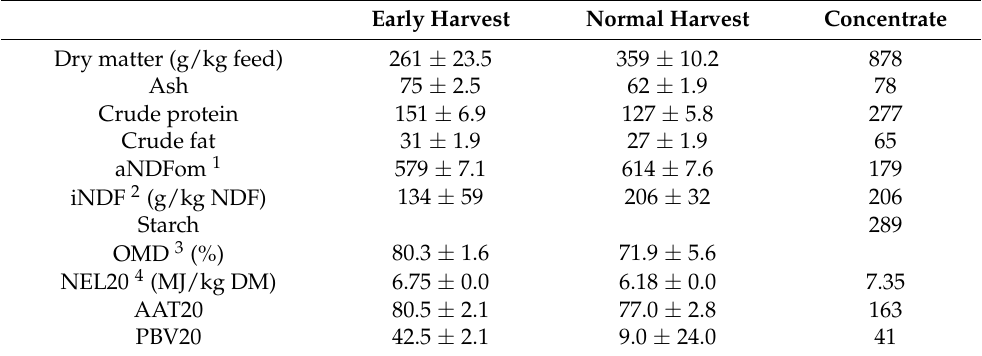
Table 1. Mean values of chemical composition and nutritional values of feeds used ( ± SD). All units in g/kg dry matter if not otherwise